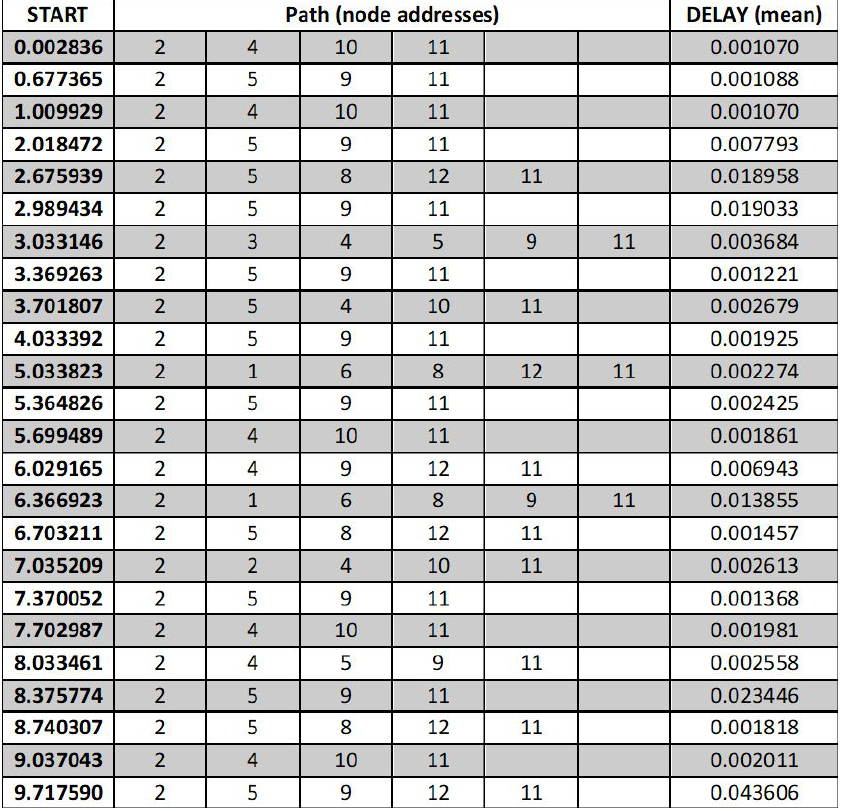
Figure 14. Switching of the paths during the experiment presented in Figure 13. Average delay times for all the flows during the whole experiment for particular meth- ods were as